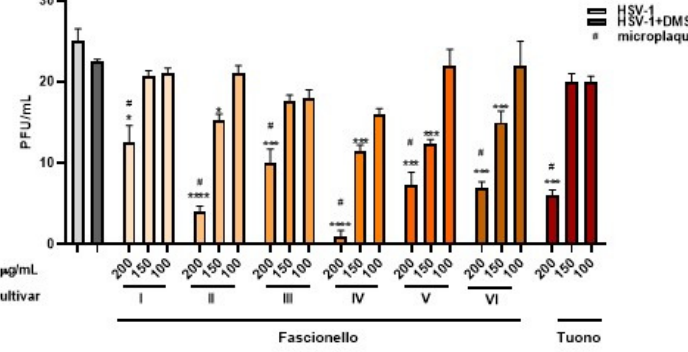
Figure 7. Effect of BSE on HSV-1 replication by plaque reduction assay. Vero cells were infected with HSV-1 dilutions for 1 h and then treated with BSE from Fascionello and Tuono cultivars (200 µ g/mL, 150 µ g/mL, and 100 µ g/mL). DMSO was included as a control. Data are expressed as mean ( ± SD) of triplicates. # indicates the micro-plaques. * p < 0.05, *** p < 0.001, **** p < 0.0001 vs. HSV-1 + DMSO. I to VI represent different producers.